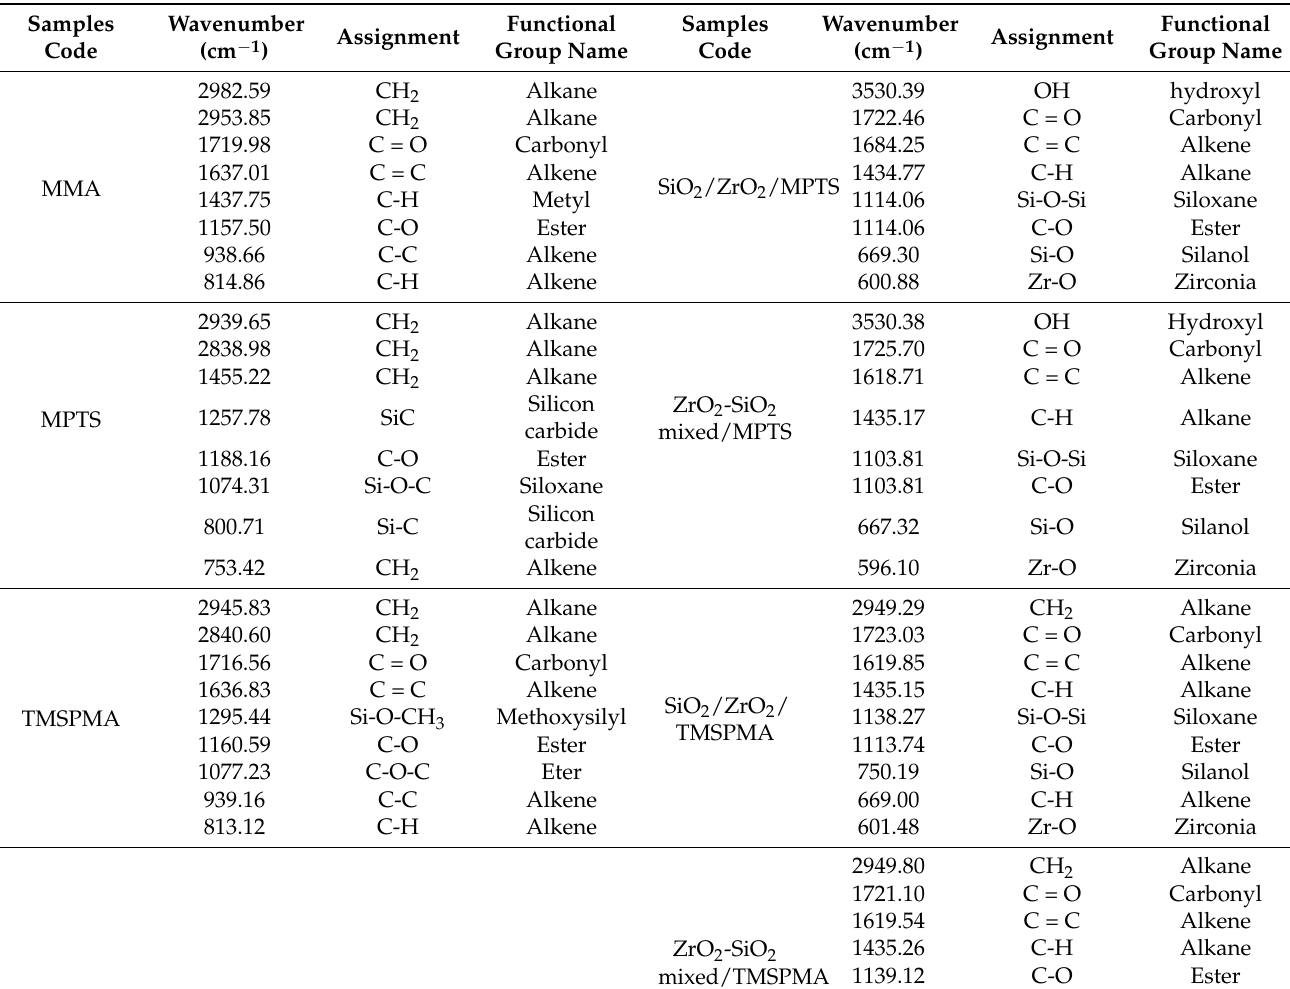
Table 3. The wavenumber range for common functional